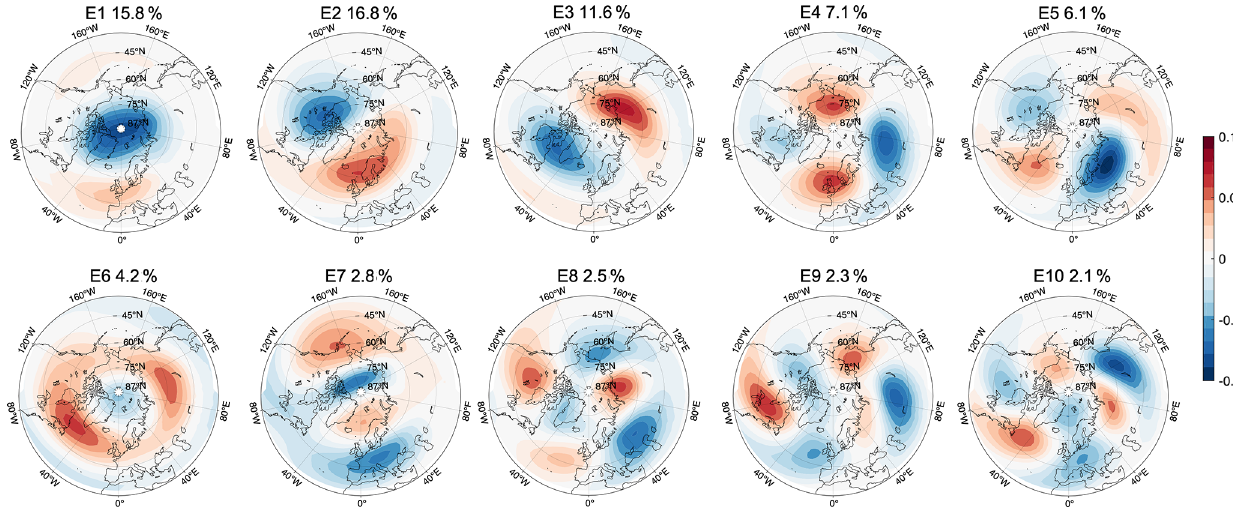
Figure 1. The first 10 EOF spatial patterns of PV at 850K ( E 1 , E 2 ,..., E 10 ) of the combined set of basis vectors as described in the text using ERA-Interim daily data. The percentage number indicates the variance explained by each